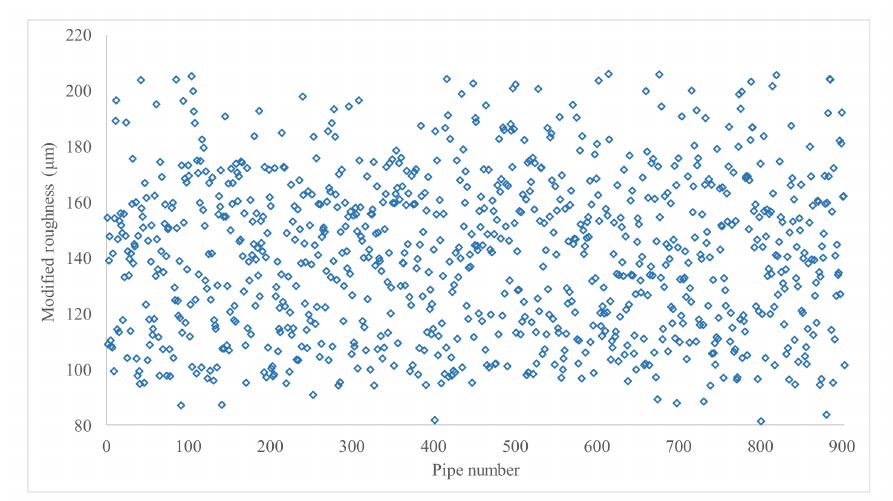
Figure 9. The calibrated value ε k of all pipes.